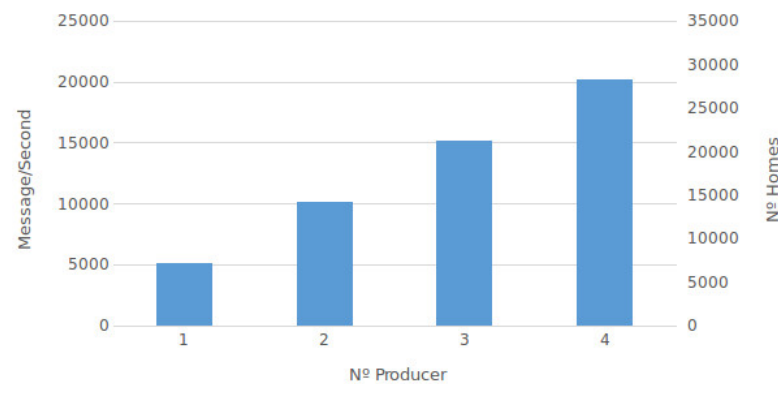
Figure 13. Kaa collector results.